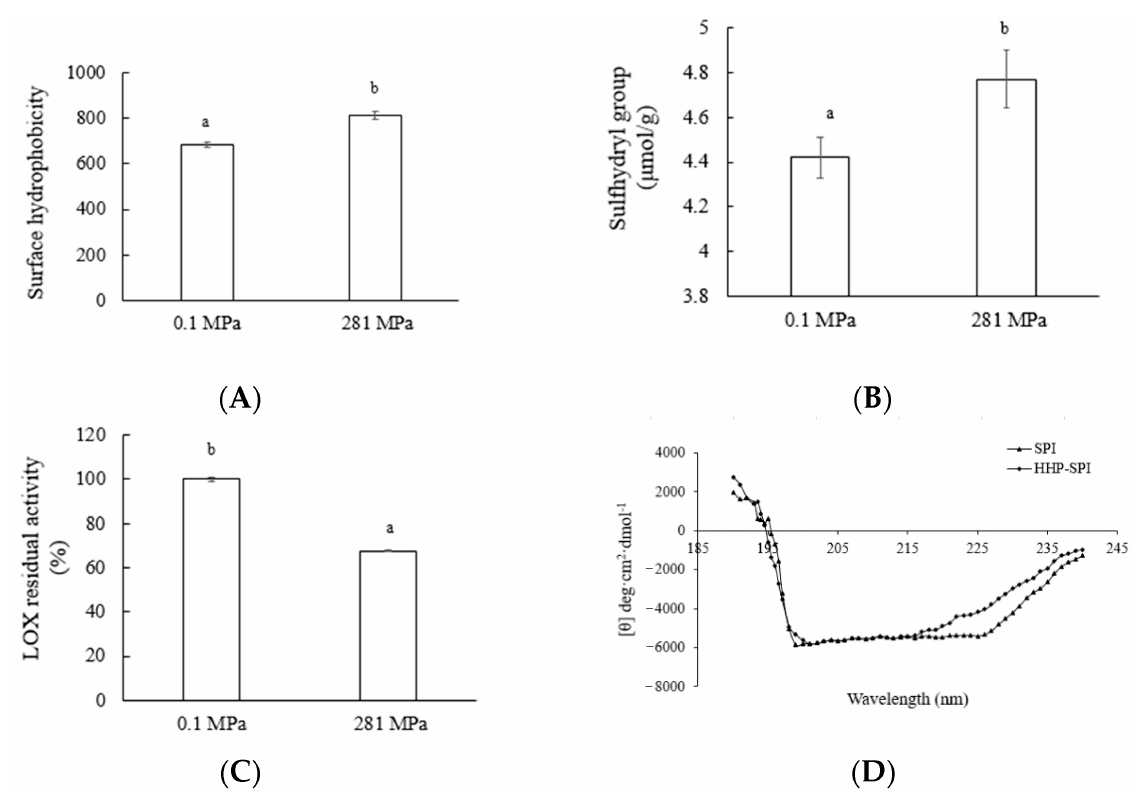
Figure 2. Physicochemical properties of soy protein isolate (SPI) (0.1 MPa) and high pressure treated SPI (HHP-SPI) (281 MPa) soybean proteins: surface hydrophobicity ( A ), sulphydryl group content ( B ), LOX residual activity ( C ), and CD spectra ( D ). Lowercase letters: statistical significance between